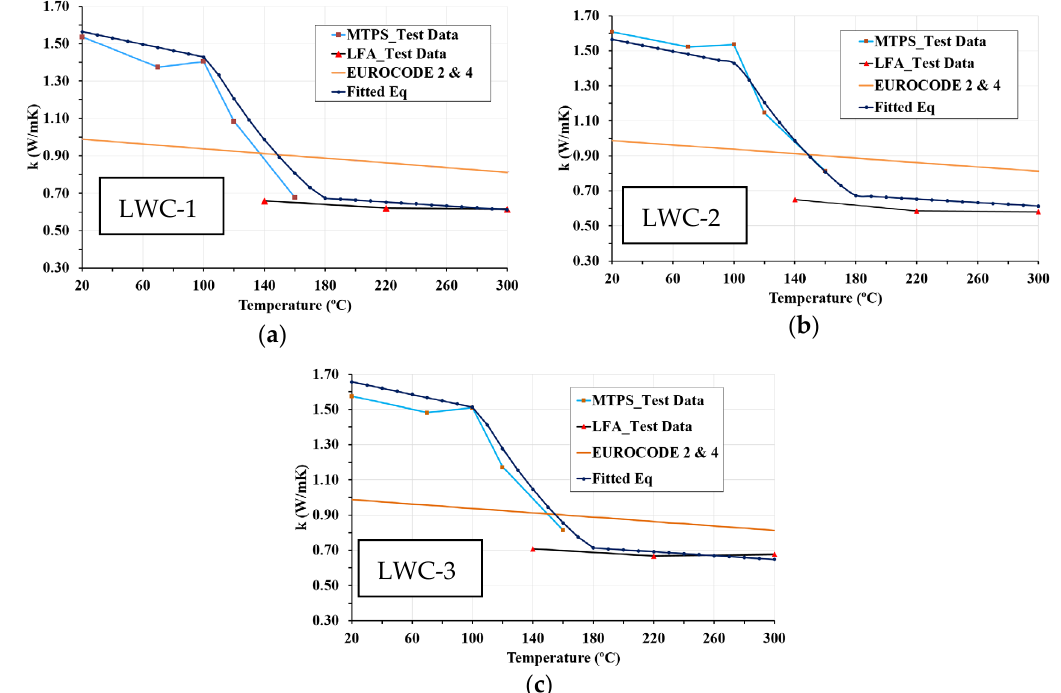
Figure 11. Comparison of the experimental and proposed thermal conductivity: ( a ) LWC-1; ( b ) LWC-2; ( c ) LWC-3.